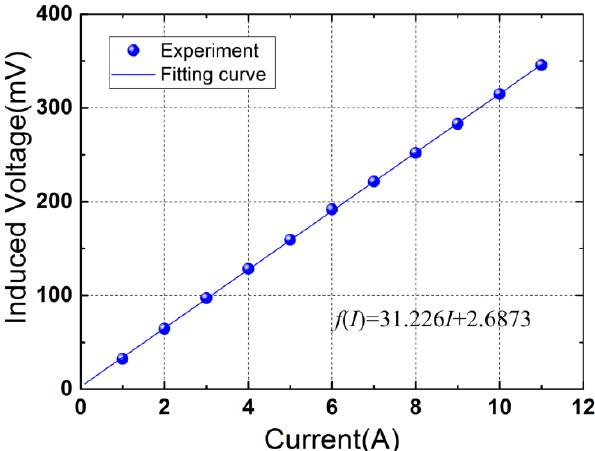
Figure 5. Induced voltage as a function of the current at the power frequency of 50 Hz.